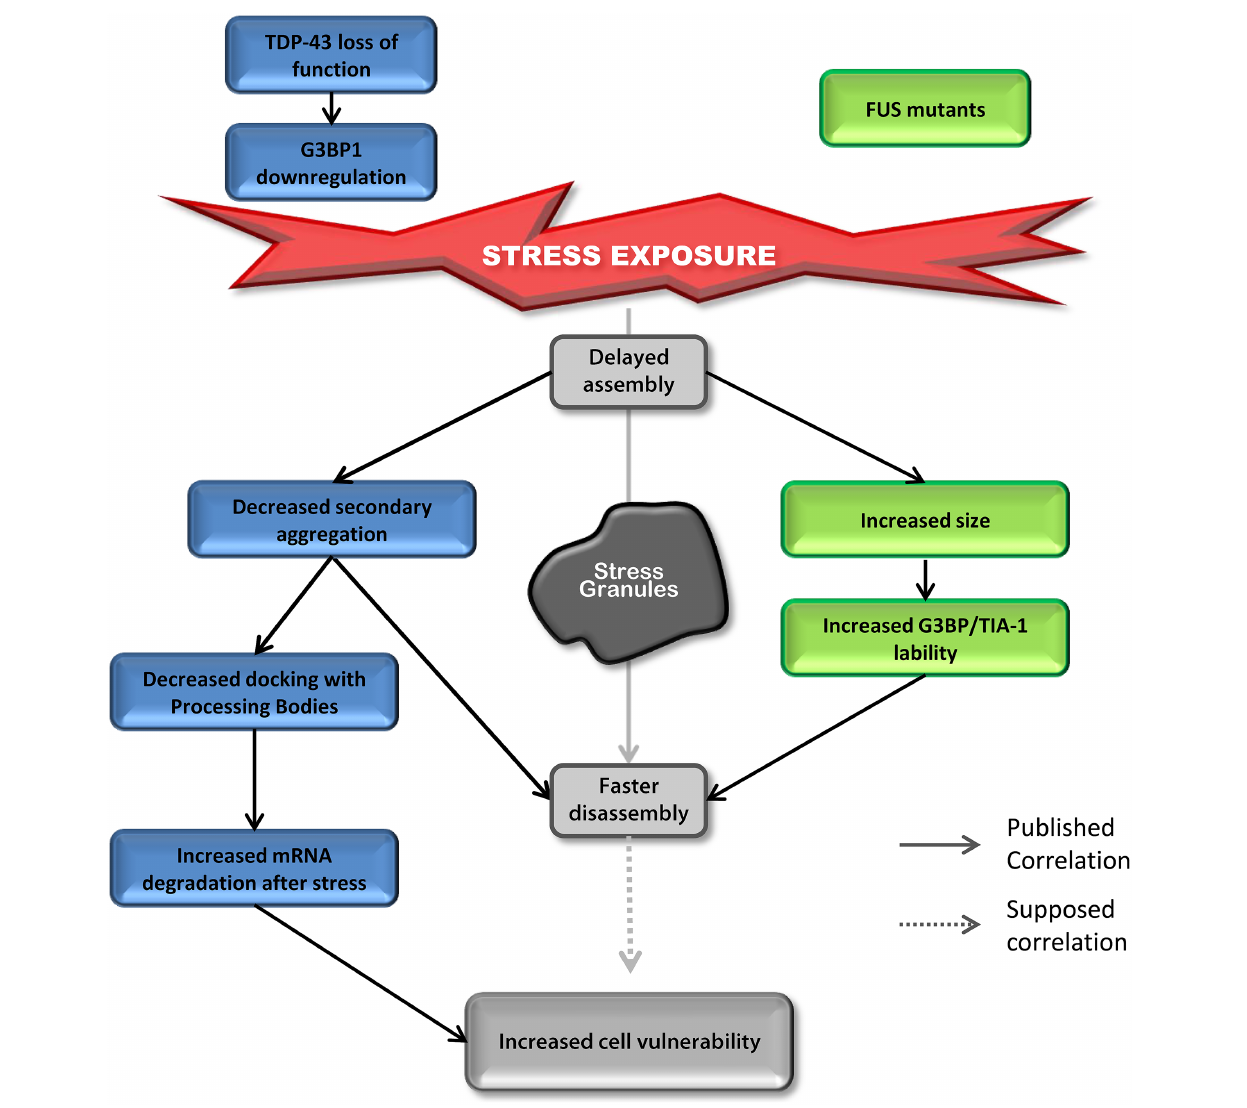
FIGURE 4 | Down-regulation of TDP-43 and expression of mutant FUS share SG phenotypes. Delayed SG assembly and faster SG disassembly is observed in cells with reduced levels of TDP-43 as well as cells expressing mutant forms of FUS. This phenotype increases cell vulnerability. Cells reduced in TDP-43 levels will present a defect in SG secondary aggregation concomitant with a decrease in SG/PB docking followed by an increase in mRNA degradation after stress (siTDP-43 cells compared to siControl cells). This effect is mediated via G3BP1. Cells expressing mutant forms of FUS form larger SGs with more labile TIA-1 and G3BP1 protein compared to cells transfected with FUS WT